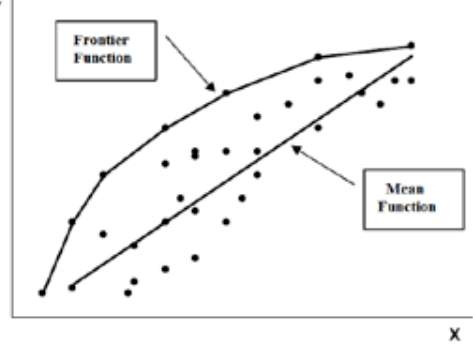
Figure 1. Representation of production